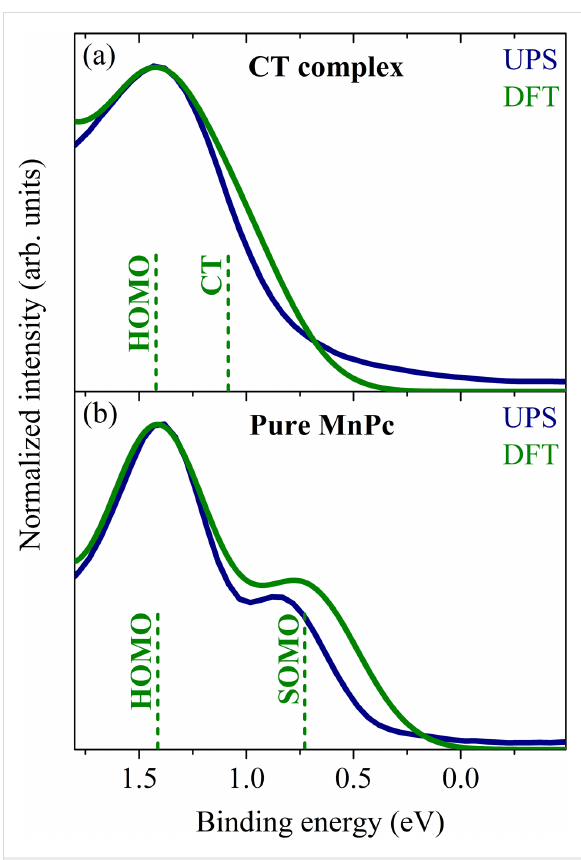
Figure 5: Comparison of valence band photoelectron spectroscopy (UPS) data to those from density functional based calculations (DFT) for pure MnPc (lower panel) and the charge-transfer compound MnPc/F 4 TCNQ (upper panel). The vertical bars denote the energy position of the molecular orbitals as determined by the calculations. For pure MnPc the two-peak structure arises from the singly occupied